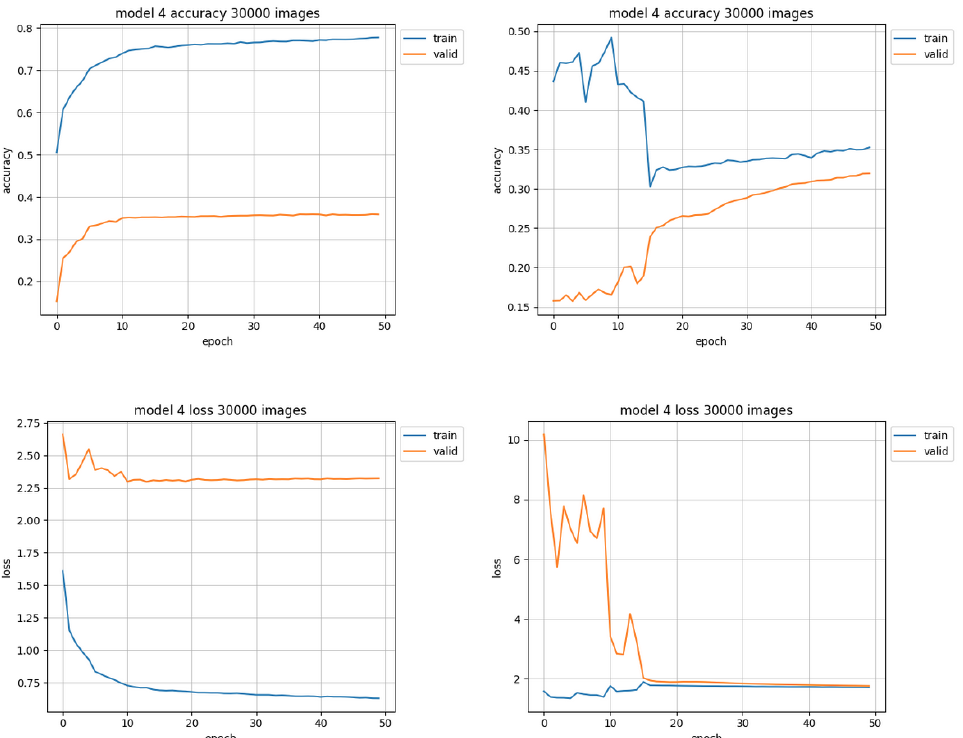
Figure 9. Training results using 30,000 images. Charts on the left side of the figure present results using unleveled data distribution, charts on the right side show results using leveled data distribution.